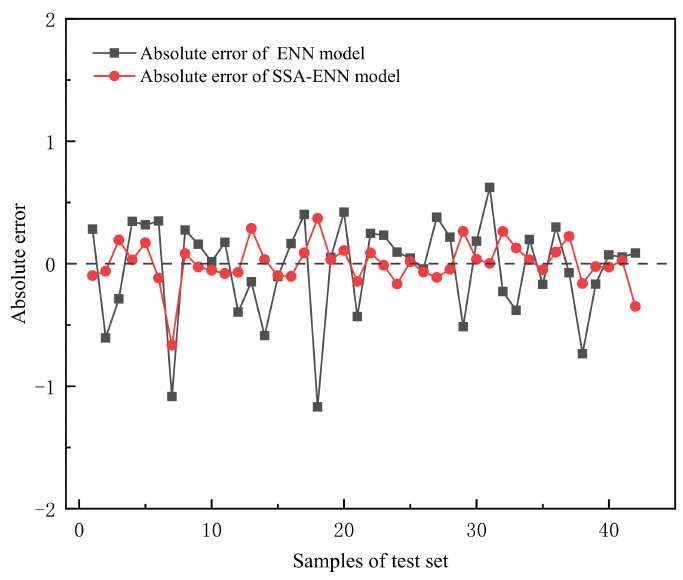
Figure 13. Absolute errors of ENN and SSA-ENN